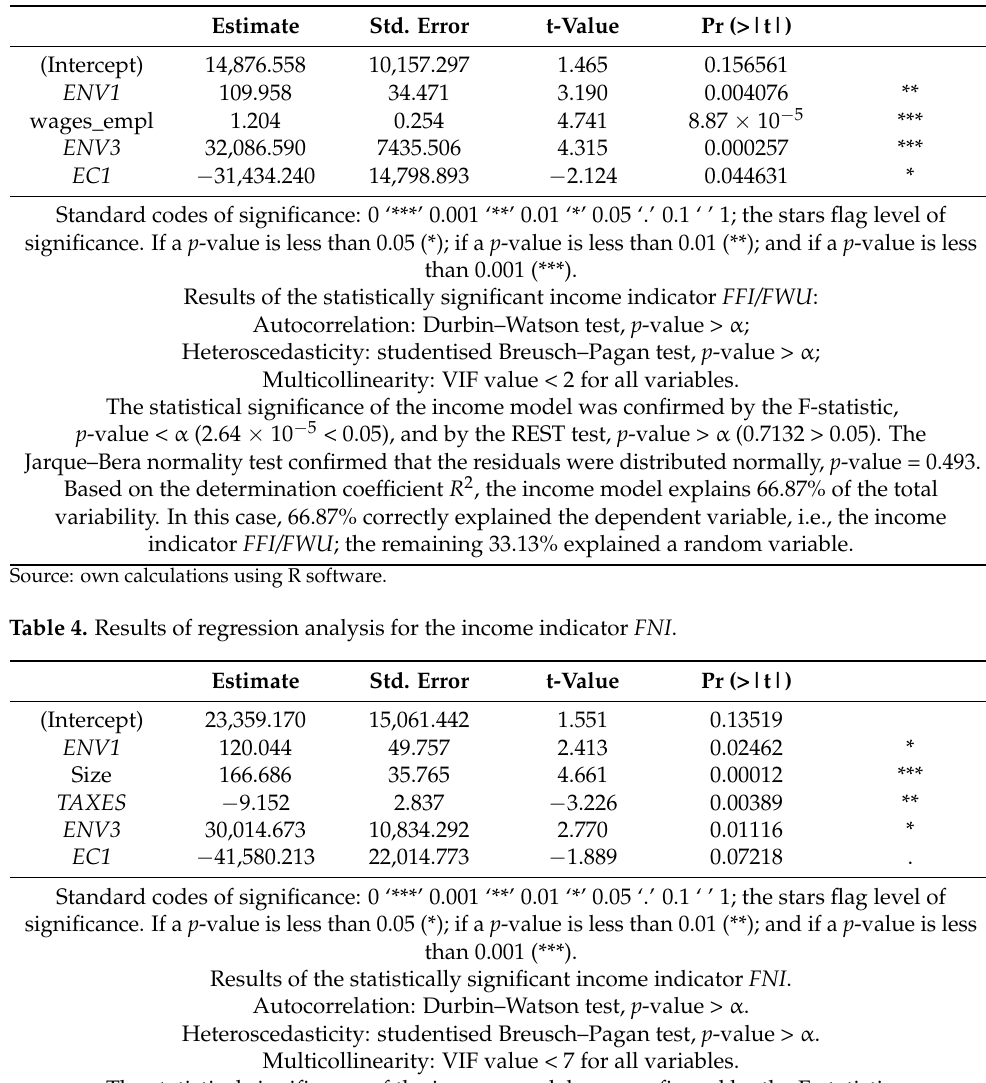
Table 3. Results of regression analysis for the income indicator FFI/FWU .